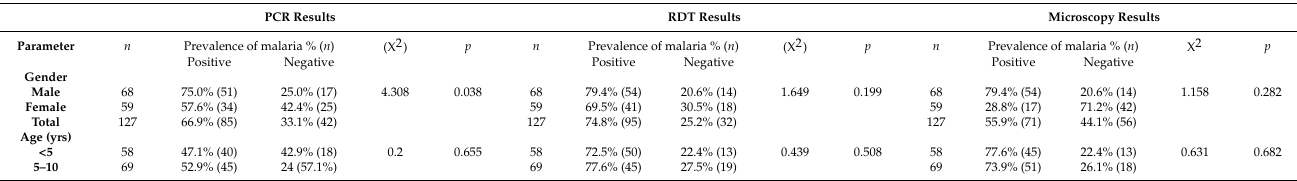
Table 3. Prevalence of asymptomatic malaria in children by a PCR, LM and an RDT by gender and age